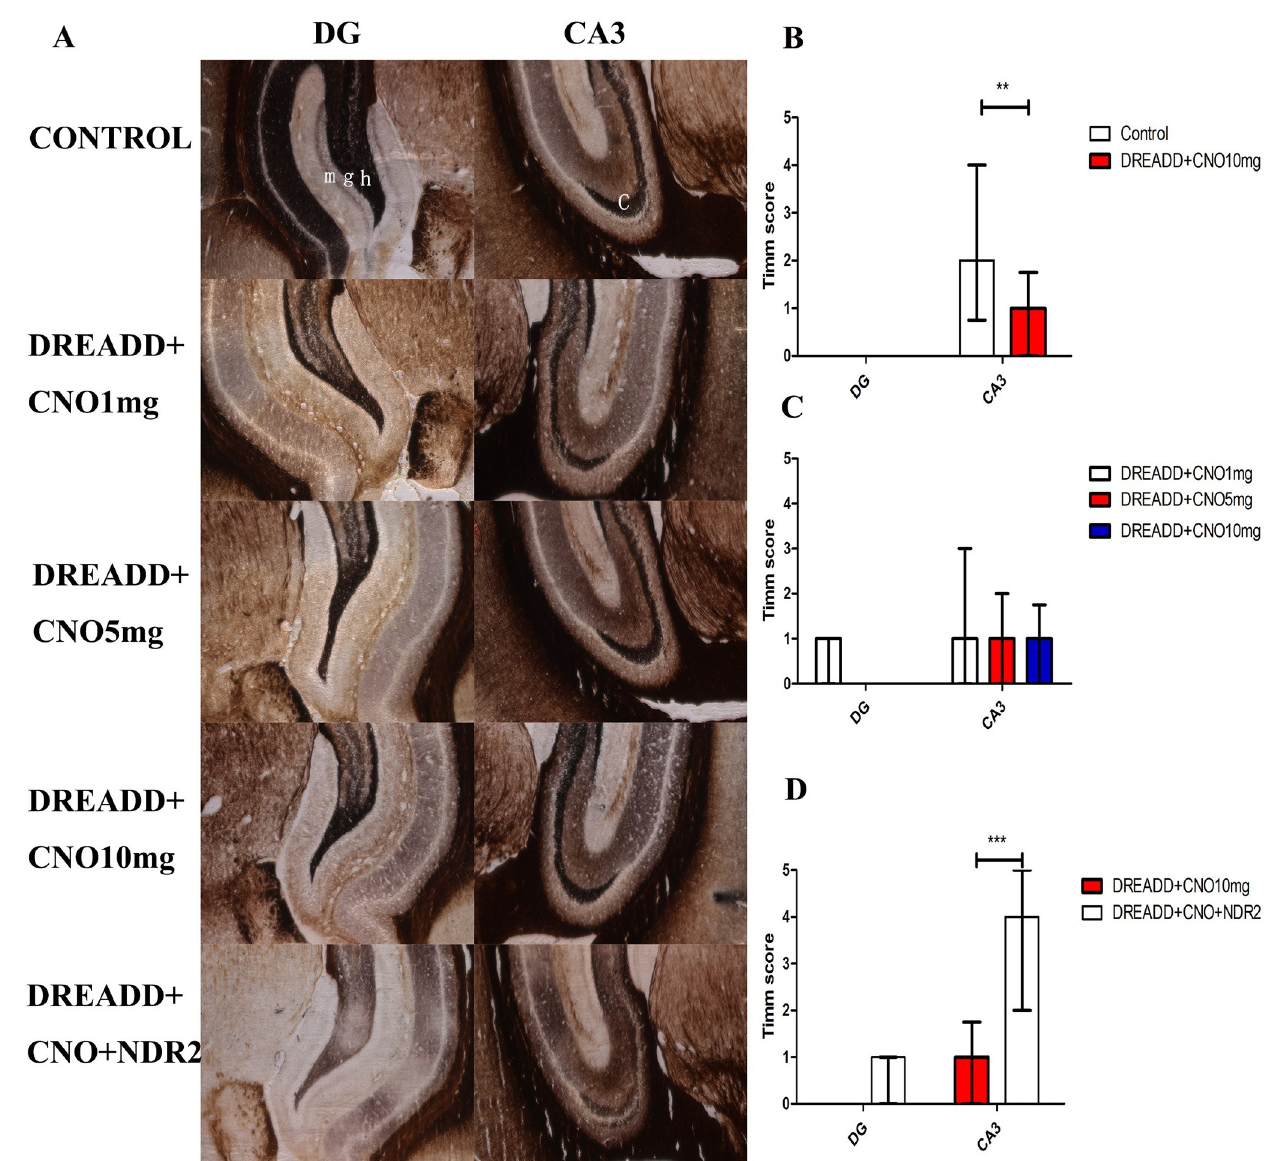
Fig 3. MFS in control, DREADD+CNO and DREADD+CNO+NDR2 groups. A, Representative pictures of MFS in the CA3 and DG regions; B, MFS of CA3 region in DREADD+CNO group(n = 6) was distinctly decreased in comparison with that in control group (n = 4, Mann-Whitney test); C, MFS of CA3 and DG were similar in DREADD rats treated with 1,5 and10 mg/kg CNO(n = 4,6 and 6 respectively, Kruskal-Wallis test); D, MFS of CA3 region in DREADD+CNO+NDR2 group(n = 5) was distinctly increased in comparison with that in DREADD+CNO group (Mann-Whitney test). CNO, clozapine N- oxide; DG, dentate gyrus; m, molecular layer; g, granule cell layer; h, hilus; c: CA3 region; All data represent the mean ± SD. * indicates P < 0.05, ** indicates P < 0.01, *** indicates P <